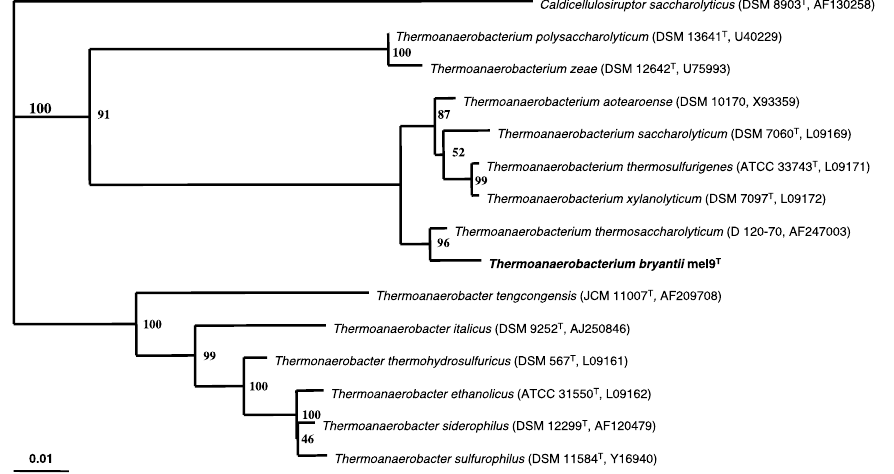
Figure 2. A phylogenetic tree showing the position of T. bryantii within the radiation of the genus Thermoanaerobacterium and related taxa. The dendrogram was constructed by the neighbor-joining method and rooted with Caldicellulosiruptor saccharolyticus. Numbers given at the nodes represent bootstrap values and indicate the percent probability for the respective branches of the tree. The bar equals 1 base substitution per 100 nucleotide positions. The GenBank accession numbers are shown in parentheses.